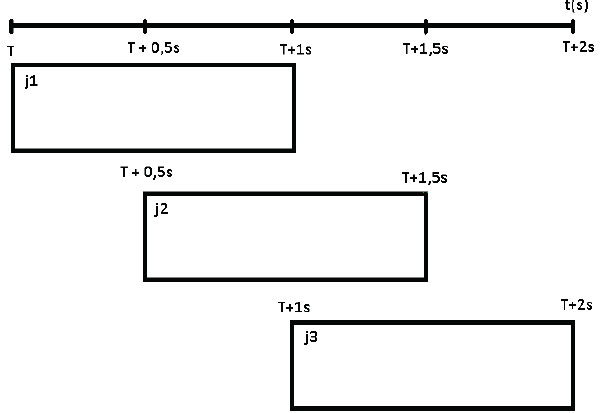
Figure 4. Windowing for a 2-s segment at 50% overlap between windows according to the Welch